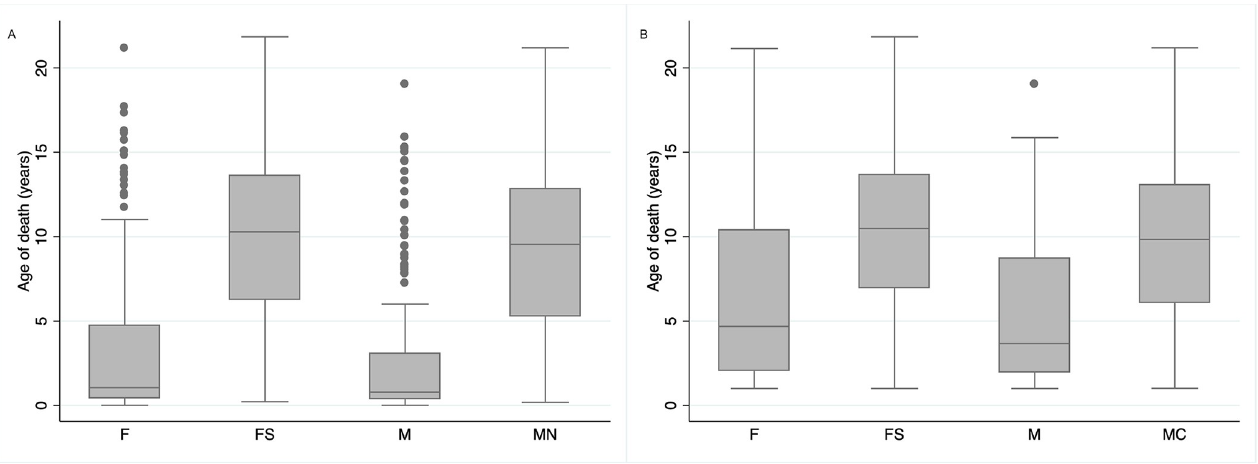
Fig 2. Spay and neuter status affects longevity in cats. (A) Box plot showing age at time of death for all cats where age was known categorized by sex. (B) Box plot showing age at time of death for all cats � 1 year where age was known categorized by sex. F = Intact Female, FS = Female spayed, M = Intact male and MN = male